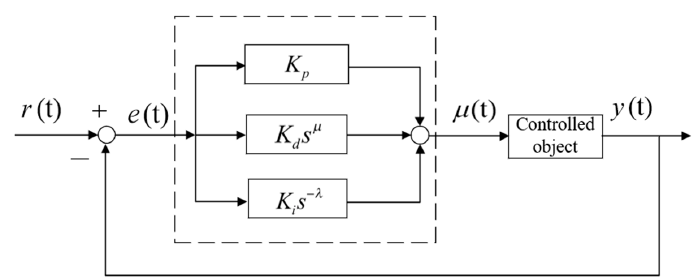
Figure 4. FOPID control structure.